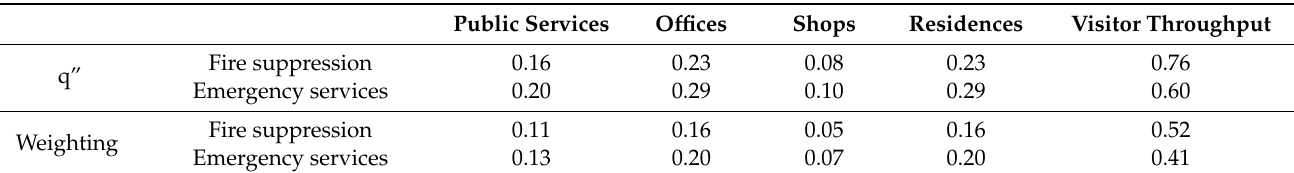
Table 3. The q” value and weights of four types of POI and visitor throughput for fire suppression and emergency